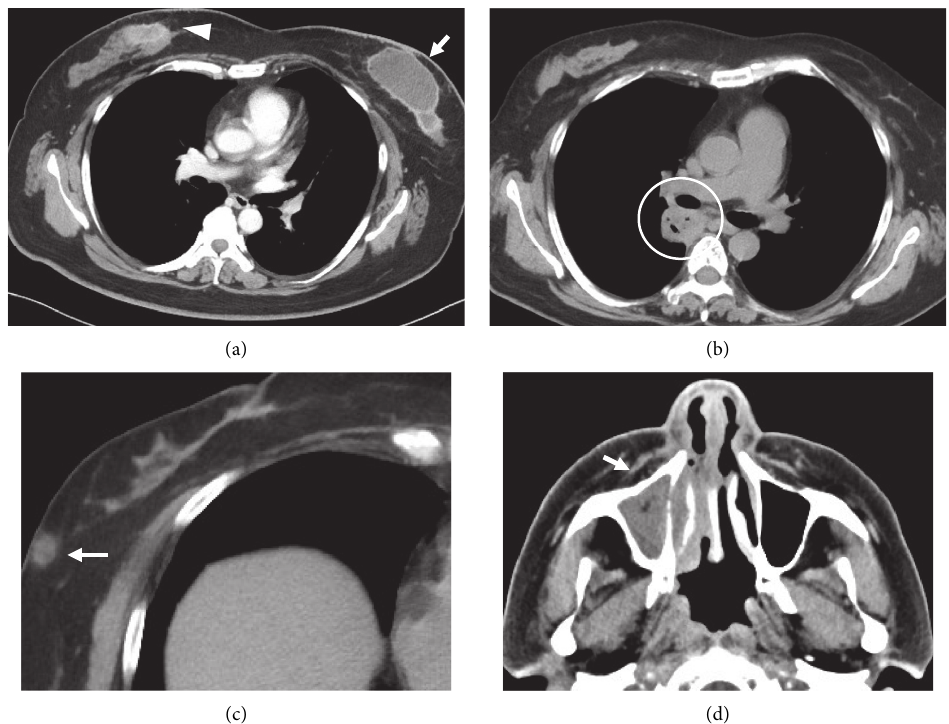
Figure 2: (a) Computed tomography showing tumor-like lesions in the patient’s breasts (right, arrowhead; left, arrow) on the first admission. (b) Whole-body computed tomography revealing pulmonary consolidation in the right lower lobe (circle). (c) A small nodule in the right breast (arrow), and (d) recurrence of right maxillary sinusitis (arrow) during the second admission.